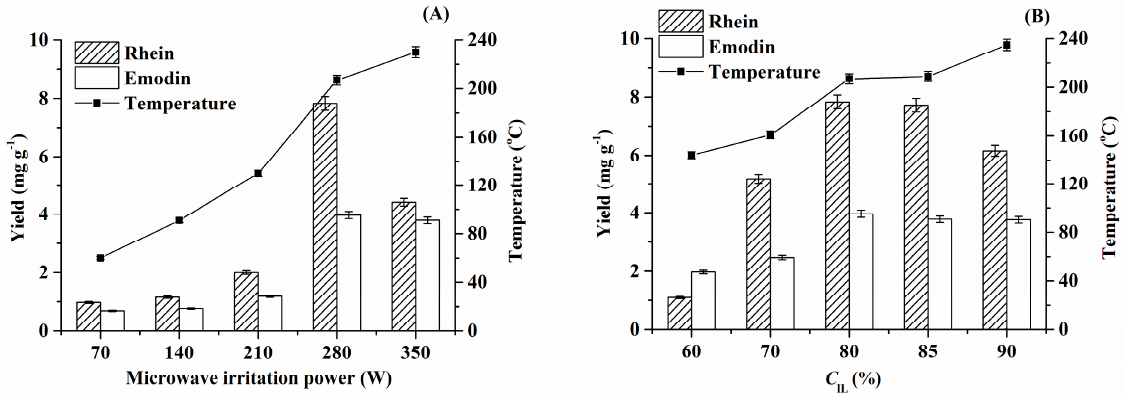
Figure 3. Influence of microwave irradiation power ( A ) (microwave irradiation time, 50 s; liquid–solid ratio, 40 g · g − 1 ; C IL = 80%) and ionic liquid (IL) concentration ( B ) (microwave irradiation power, 280 W; liquid–solid ratio, 40 g · g − 1 ; microwave irradiation time, 50 s) on the extraction efficiency.